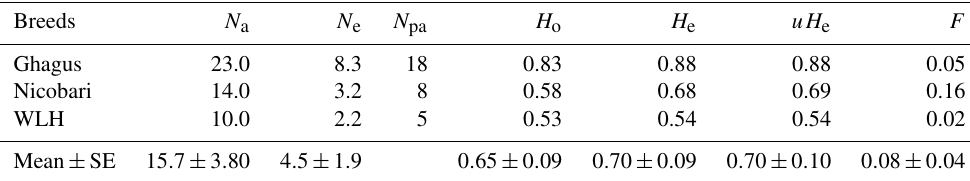
Table 2. Effective number of alleles, heterozygosity and fixation index in three chicken breeds. Breeds N a N e N pa H o H e uH e F Ghagus 23.0 8.3 18 0.83 0.88 0.88 0.05 Nicobari 14.0 3.2 0.58 0.68 0.69 0.16 WLH 10.0 Mean ± SE